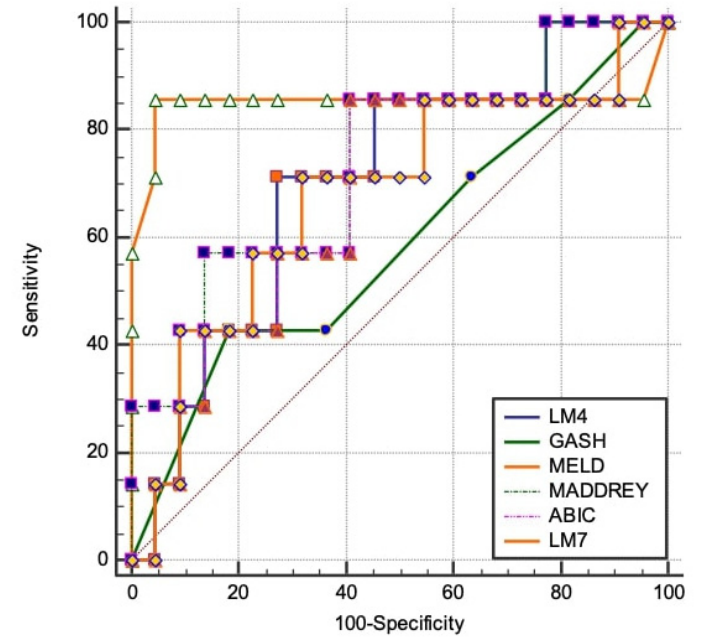
Figure 5. Comparison of AUROCs in order to find the best model for predicting 28-day mortality. The best performance to predict mortality was observed in the MELD score with an AUC of 0.85, followed by the Maddrey score with an AUC of 0.74 and by LM7 and LM4 with AUCs of 0.68 and 0.67, respectively.